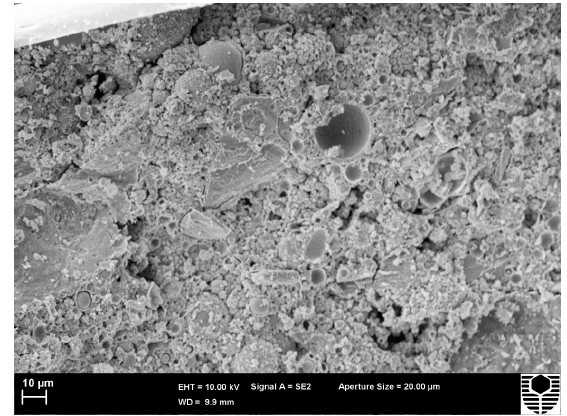
Figure 5. C1.82PP as cured (AC) fracture surface image.